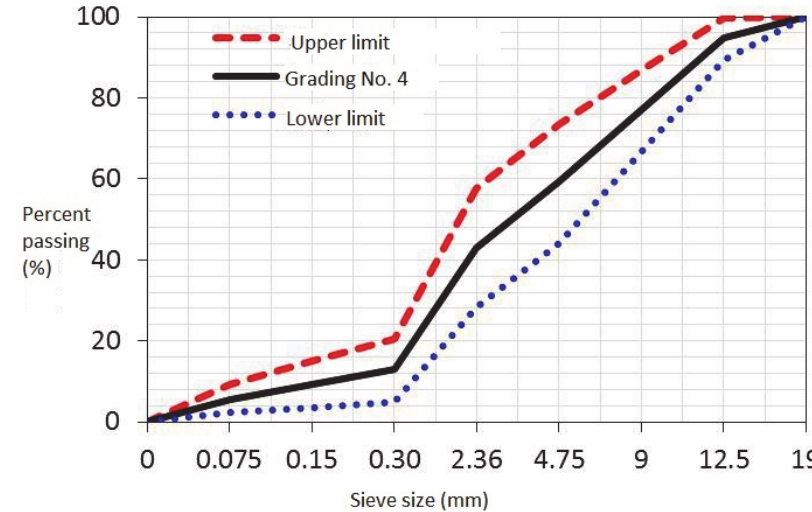
Figure 1: Particle size distribution for stone mastic asphalt mixture.